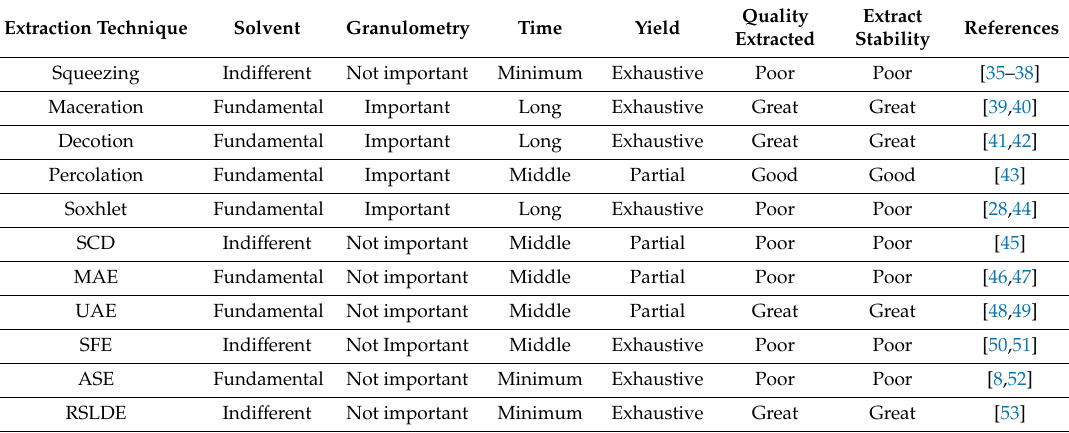
Table1. ComparisonandmaincharacteristicsofSolid-Liquidextractiontechniquesarehereinpresented. Extraction